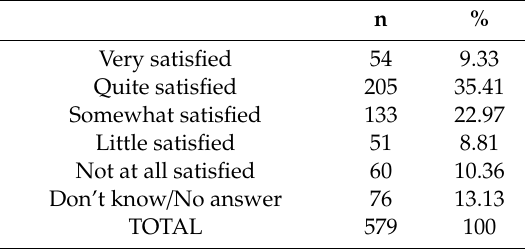
Table 2. Degree of satisfaction with aquaculture fish as food.